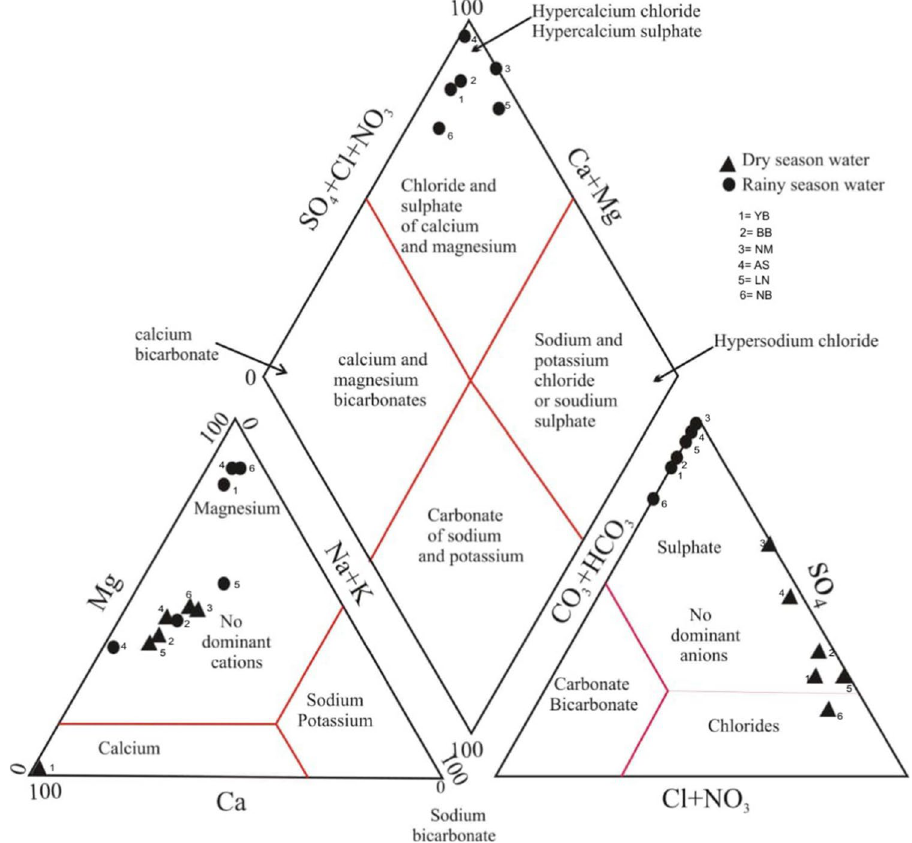
Fig. 6 Piper diagram showing variation in ion composition of the Mezam River